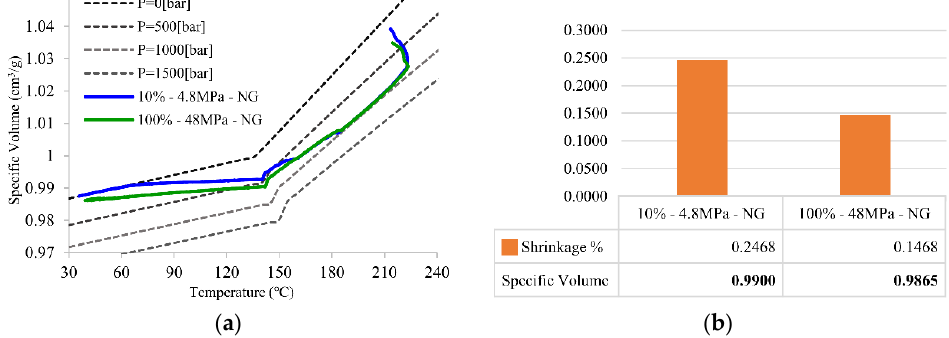
Figure 12. ( a ) PVT processing path of principle of intermittent packing pressure setup and ( b ) the final specific volume and its shrinkage for NG section.